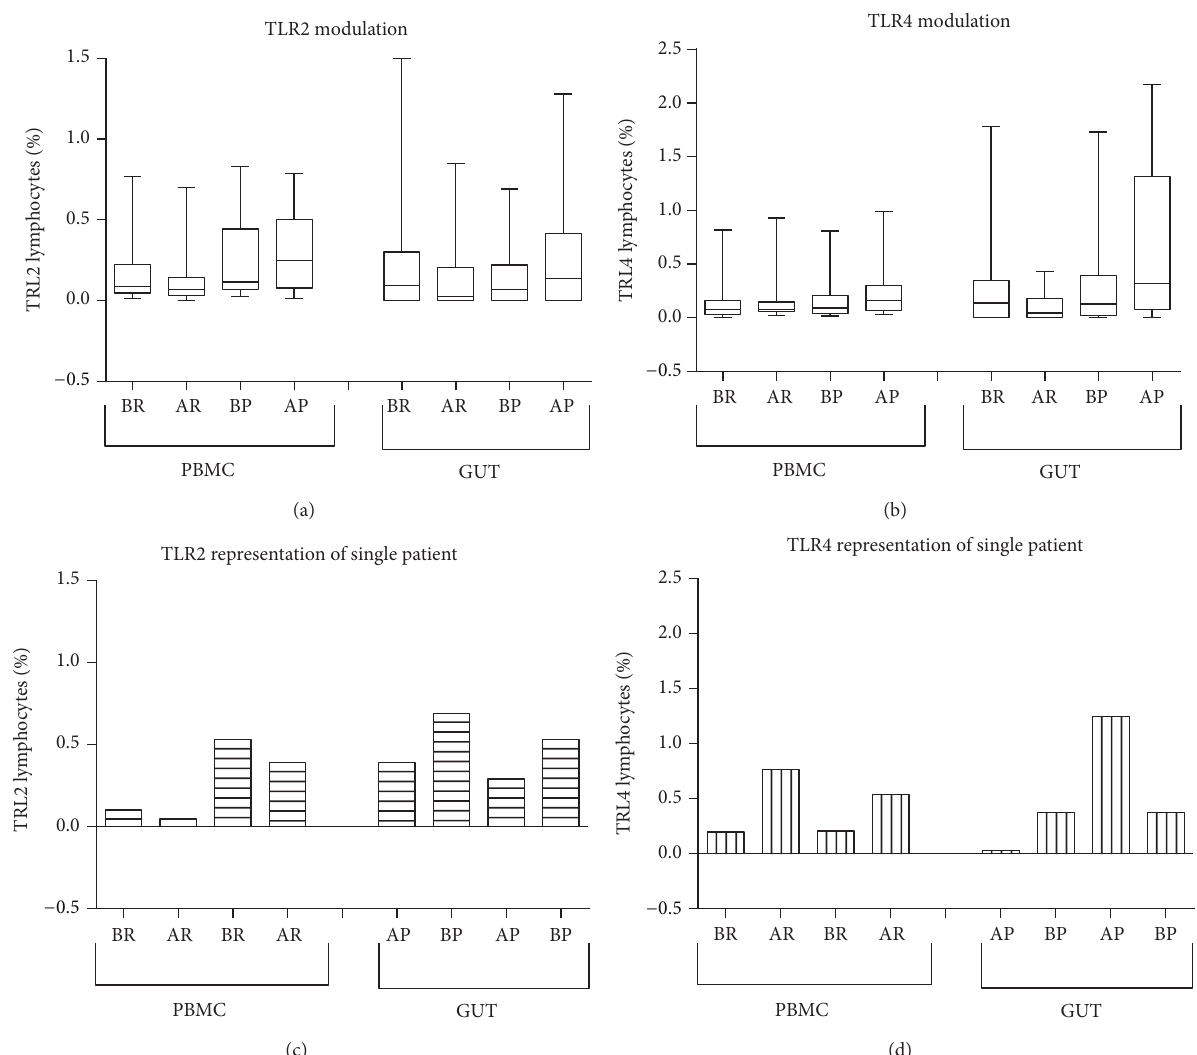
BP0.00.51.01.5 Figure 2: Modulation of TLR2 and TLR4 lymphocytes in PBMC and gut. (a, b) The comparison of modulation of TLR2 and TLR4 expression inthedifferentpatientgroupsbetweenPBMCandgut(beforeandafterplaceboorRifaximin).(c-d)ModulationofTLR2andTLR4expression observedinasinglerepresentativepatient.Thevaluesreportedinbox-and-whiskersplotsshowtheminimum,the25thpercentile,themedian, the 75th percentile, and the maximum. In particular, the whiskers go down to the smallest value (minimum) and up to the largest one (maximum),thetopandbottomoftheboxarethe25thand75thpercentiles,andthelineinthemiddleoftheboxisthemedian,corresponding to 50th percentile, evaluated before Rifaximin (BR), after Rifaximin (AR), before placebo (BP), and after placebo (AP). recruitment of lymphocytes. We analyzed CD103 expression in peripheral blood and in sigmoid and transverse mucosa